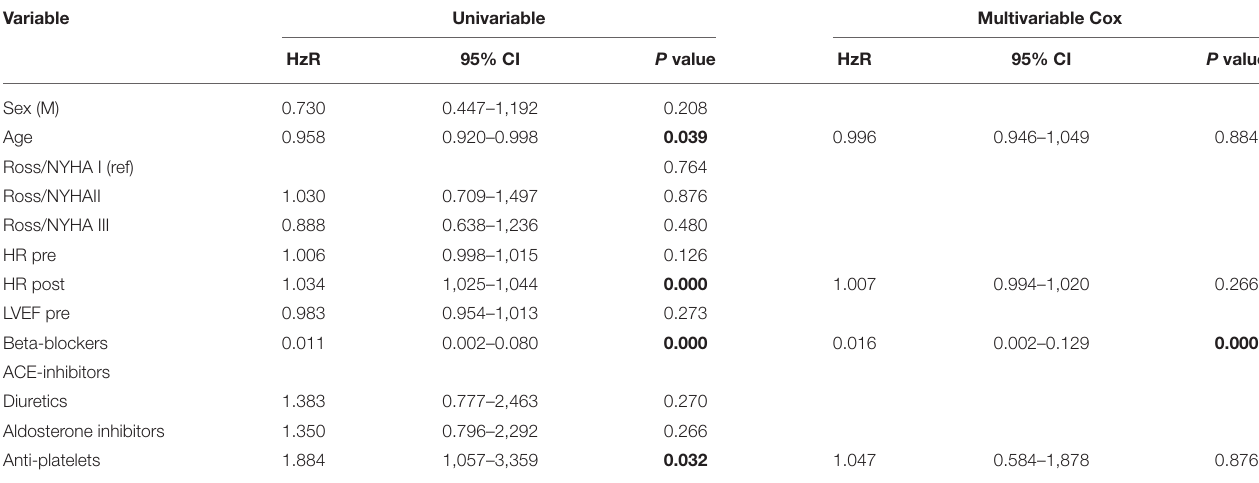
TABLE 2 | Results of univariable and multivariable Cox regression for long-term outcomes.